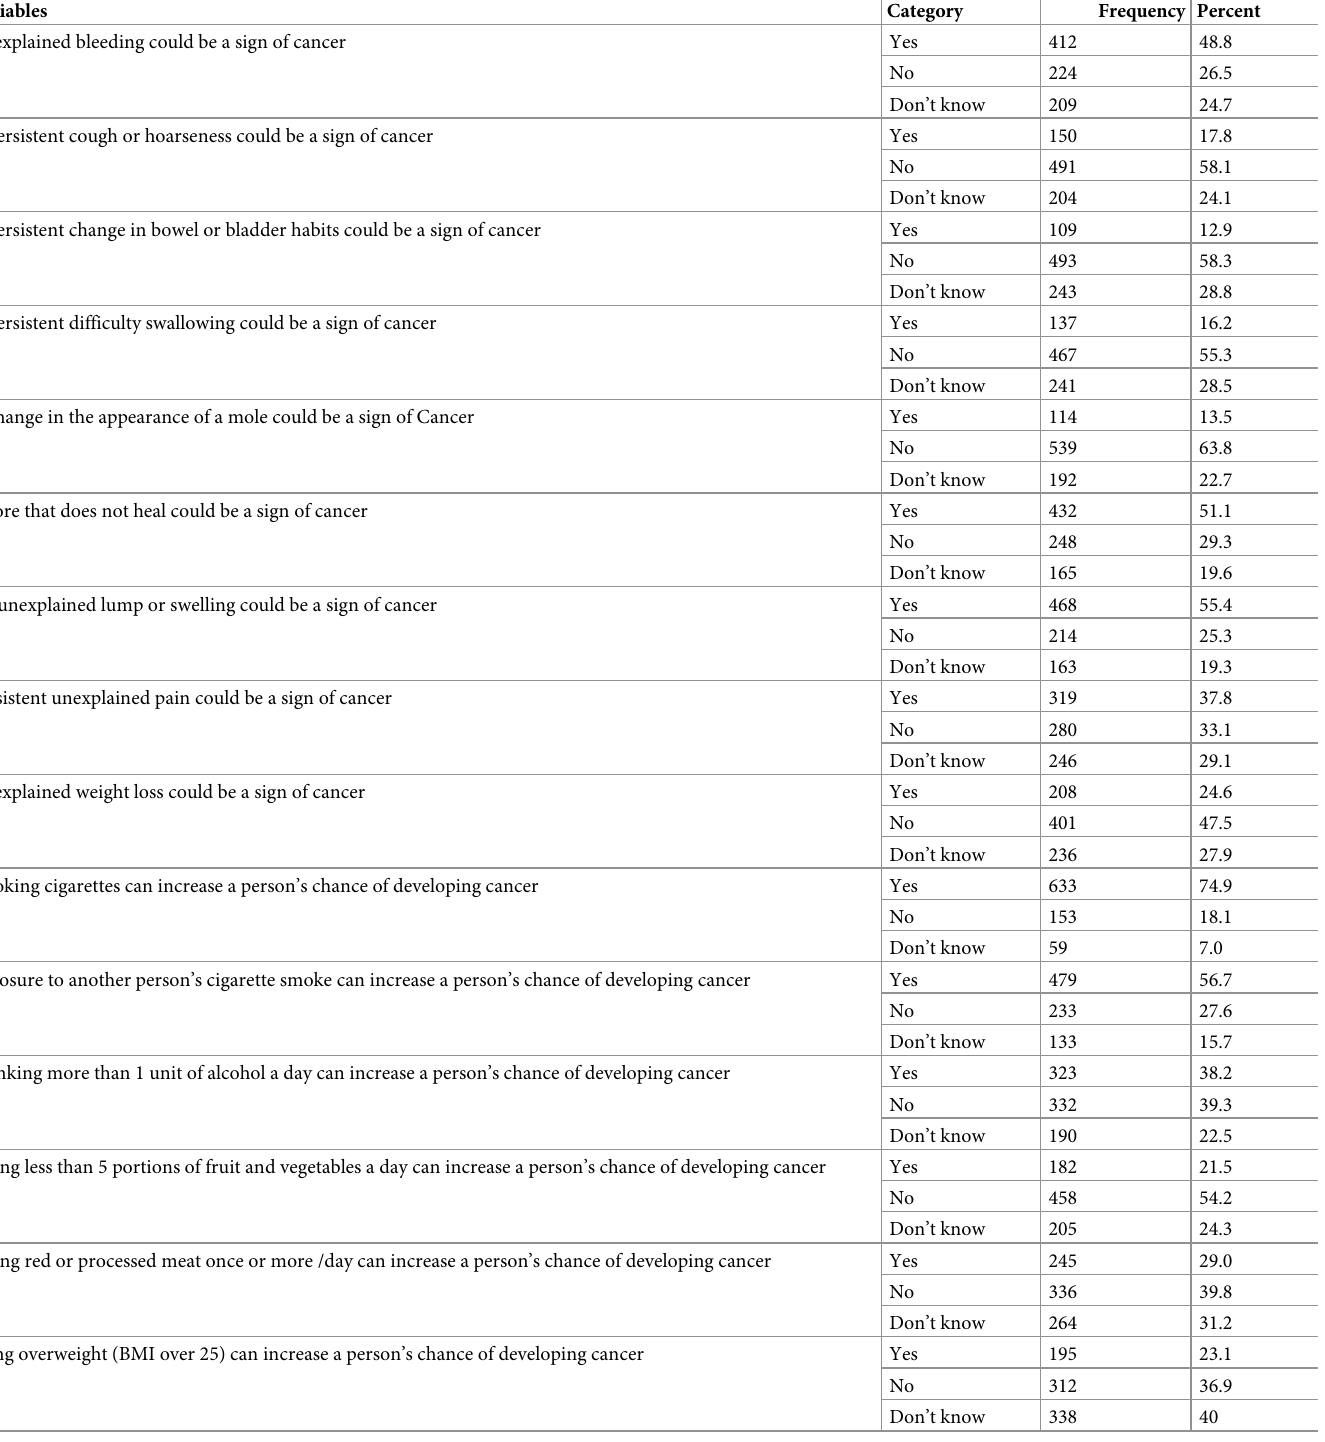
Table 2. Awareness regarding risk factors of cancers in the study participants of Bahir Dar city, northwest Ethiopia 2019, (n =